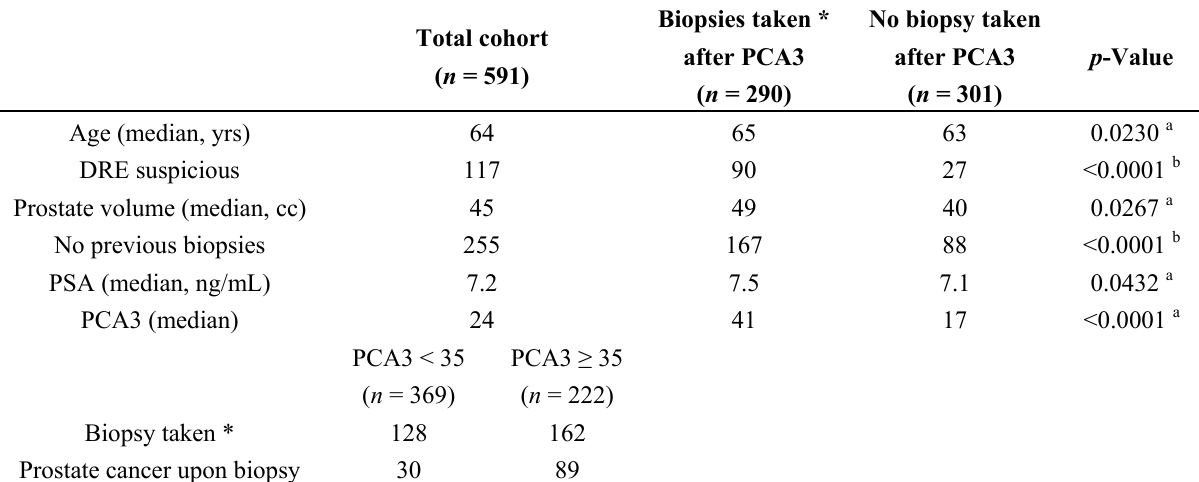
Table 1. Patient characteristics and biopsy results.